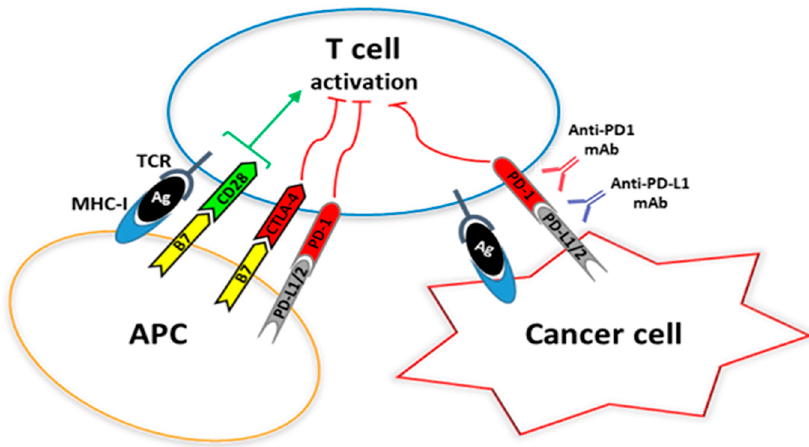
Figure 1. Inhibitory effect of the immune checkpoint receptors CTLA4 and PD-1 on T cell activation. T-cell activation depends on two simultaneous signals: a) interaction of the T-cell receptor with the complex MHC-antigenic peptides; b) co-stimulation by CD28 binding to CD80/CD86. The alternative ligation of CD80/CD86 to CTLA4, as well as the interaction between PD-1 and PD-L1/L2, lead to T-cell exhaustion. TCR, T cell receptor; MHC-I, major histocompatibility complex class I; CTLA-4, Cytotoxic T-Lymphocyte Antigen 4; PD-1, programmed cell death 1; PD-L1/2, PD-1 ligand 1 and 2; APC, Antigen presenting cells.